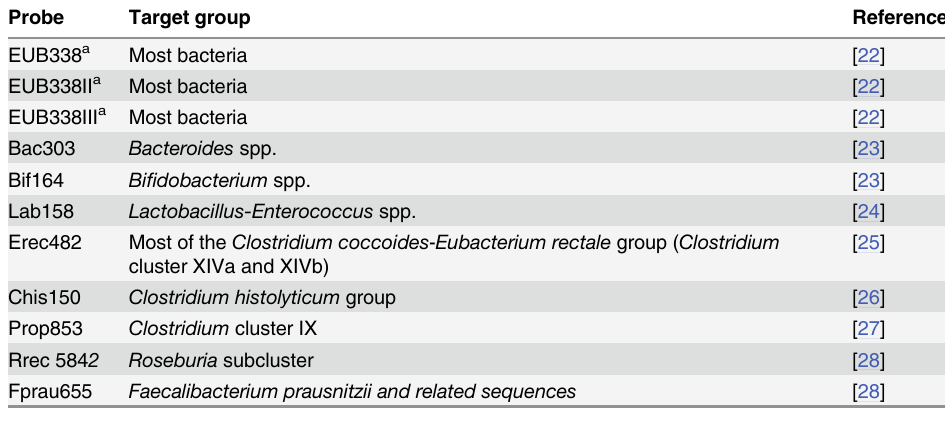
Table 3. Oligonucleotide probes used in this study for FISH